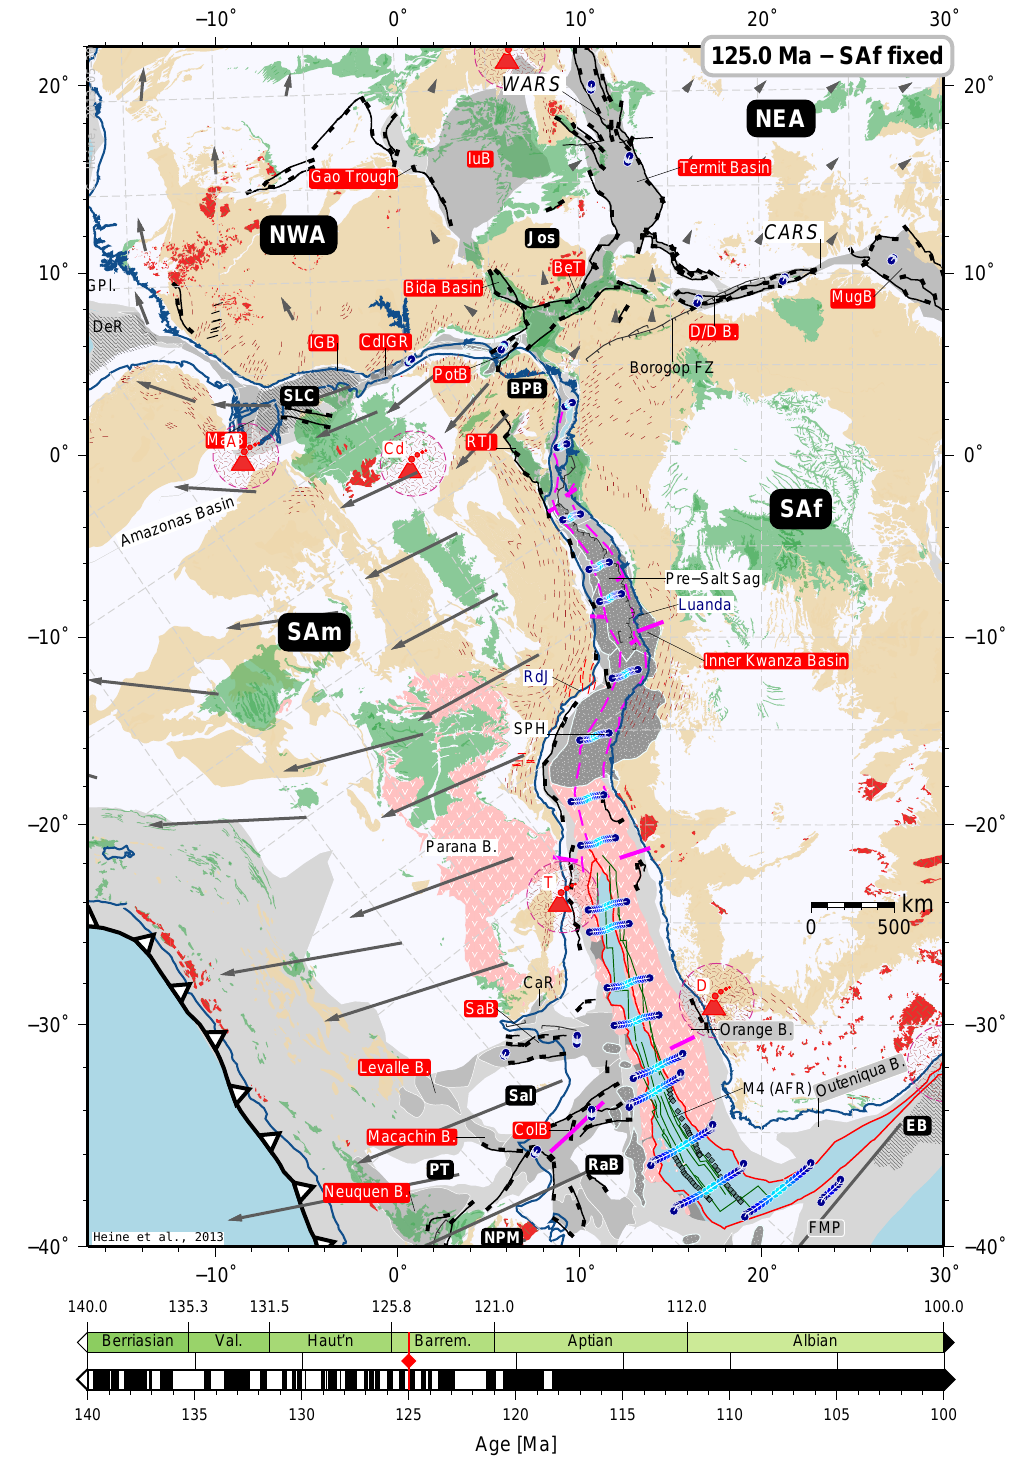
Fig. 17. Plate tectonic reconstruction at 125Ma, with Africa fixed in present-day coordinates. For map legend see Fig. 22, abbreviations as in Fig. 13. Note that at this time, the west African pre-salt basin width is generated and seafloor spreading is abutting against the Walvis Ridge/Florianopolis Ridge at the southern margin of the Santos Basin, with extension and possible rifting along the Abimael Ridge in the inner SW part of the Santos Basin (cf. Scotchman et al., 2010). Relative rotation of SAm to NWA results in ≈ 20km of transpression between the Guinea Plateau and the Demerara Rise. Rift basins along the equatorial Atlantic rift are all actively subsiding. Additional abbreviations: SPH – S˜ao Paulo High; EB – Maurice Ewing